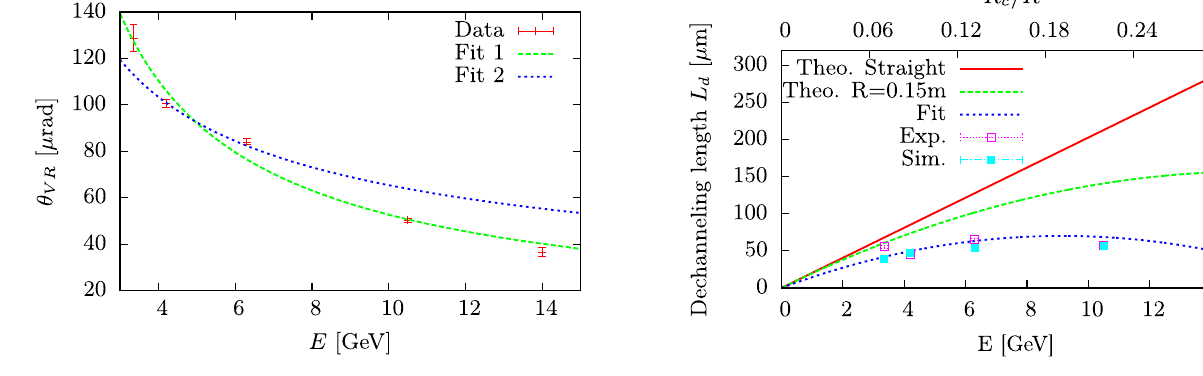
FIG. 17. The angle of volume reflection is fitted with a power function (Fit 1) and to a function of the type a=